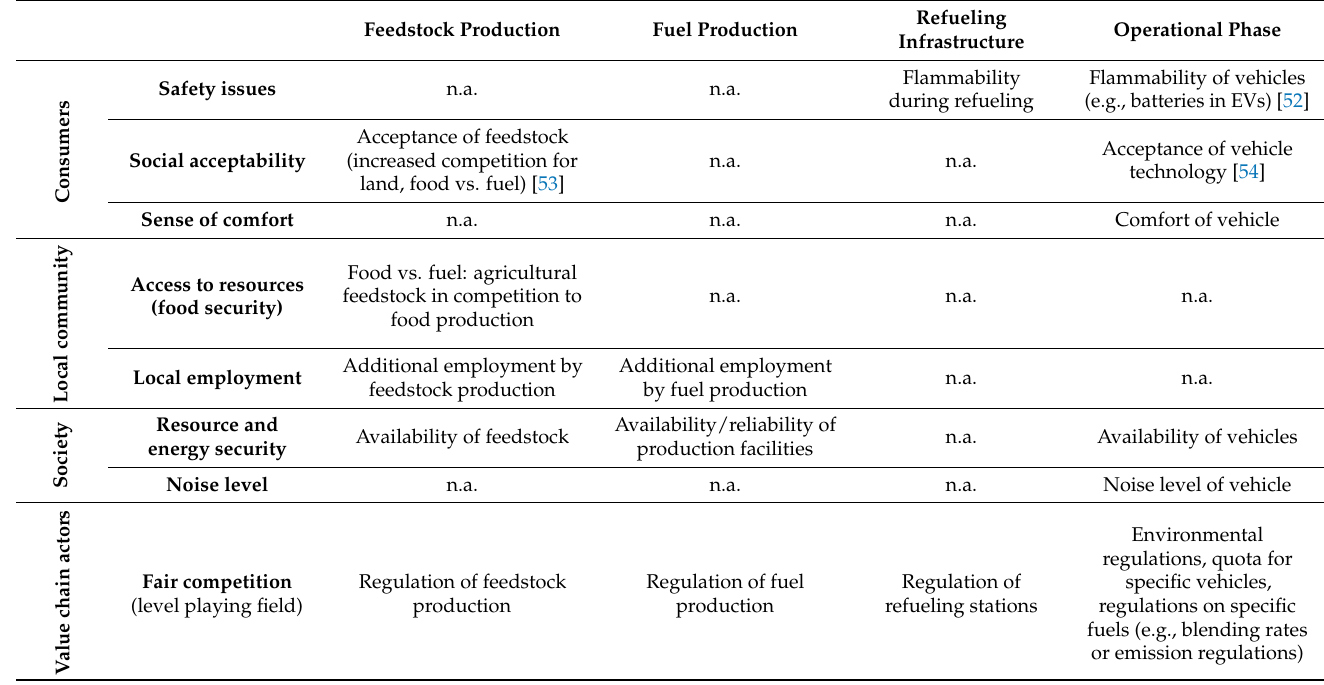
Table 6. Social criteria sorted by stakeholder group and criteria categories along the unit